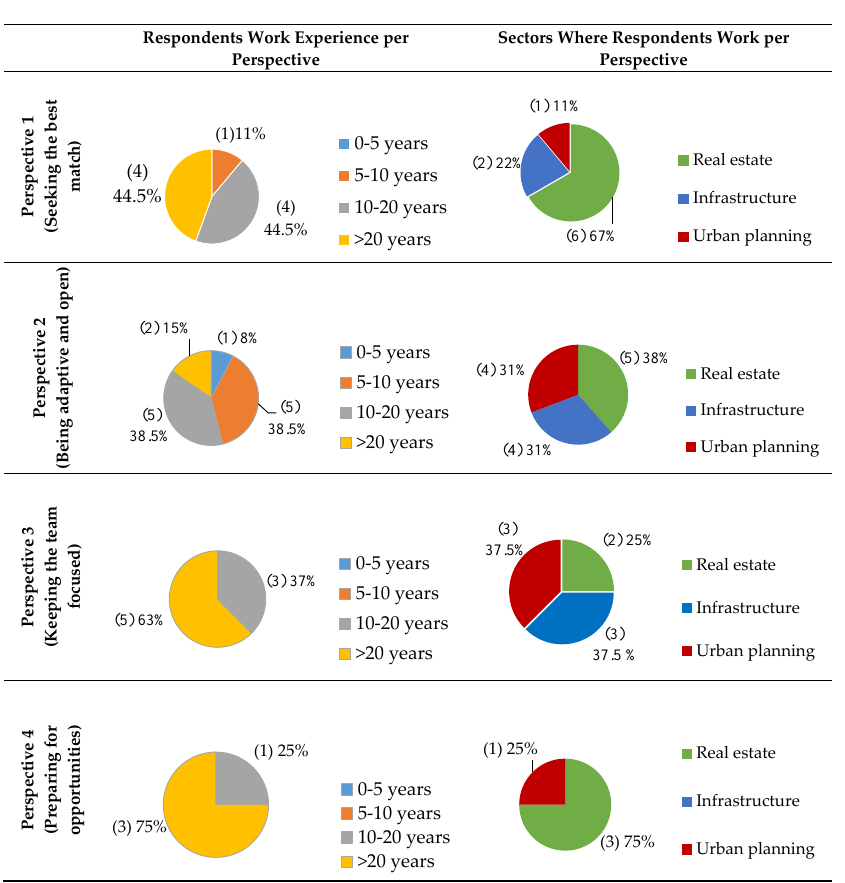
Table A4. Success criteria framework used for this